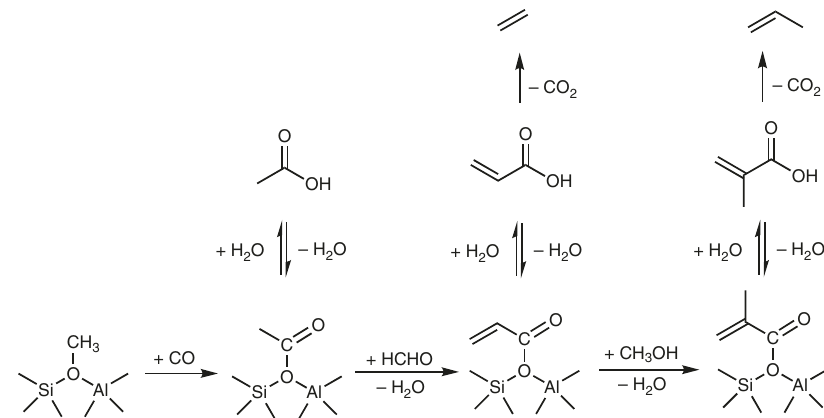
Fig. 3 Schematic illustration of the proposed reaction pathways for the formation of alkenes. Surface methoxy group undergoes carbonylation into acetyl group and desorbs as acetic acid, which stepwise converts to unsaturated carboxylic acid, e.g. acrylic acid and methacrylic acid. Ethene and propene are formed via decarboxylation of the unsaturated carboxylic